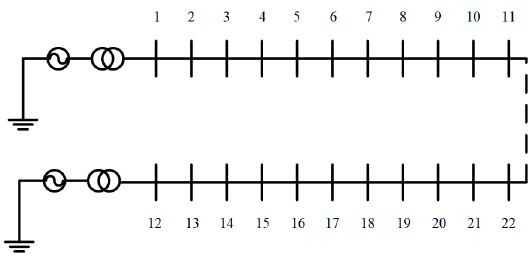
Figure 13. Simple 22-bus distribution system.